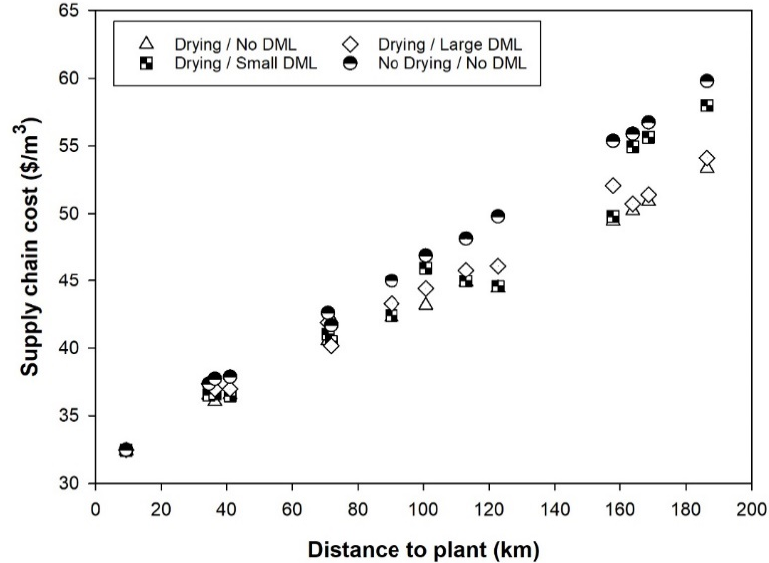
Figure 11. Supply chain costs per m 3 by transport distance and scenario.